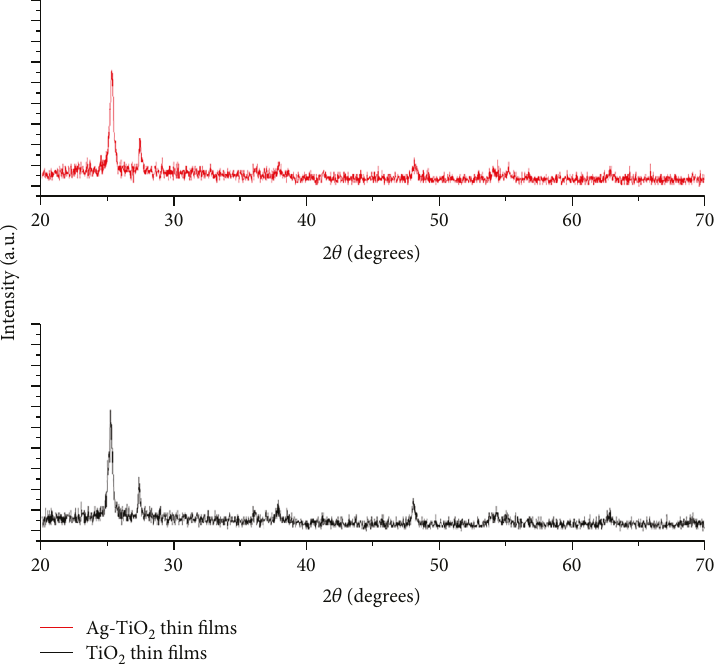
Figure 4: XRD pattern for both TiO